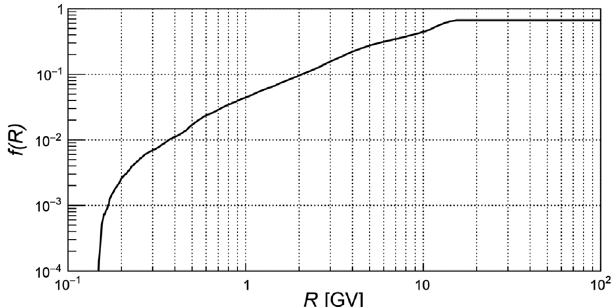
Fig. 1. Transmission function f ( R ) for the average ISS orbit including geomagnetic shielding and a shadowing factor f X = 0.67 for an altitude of